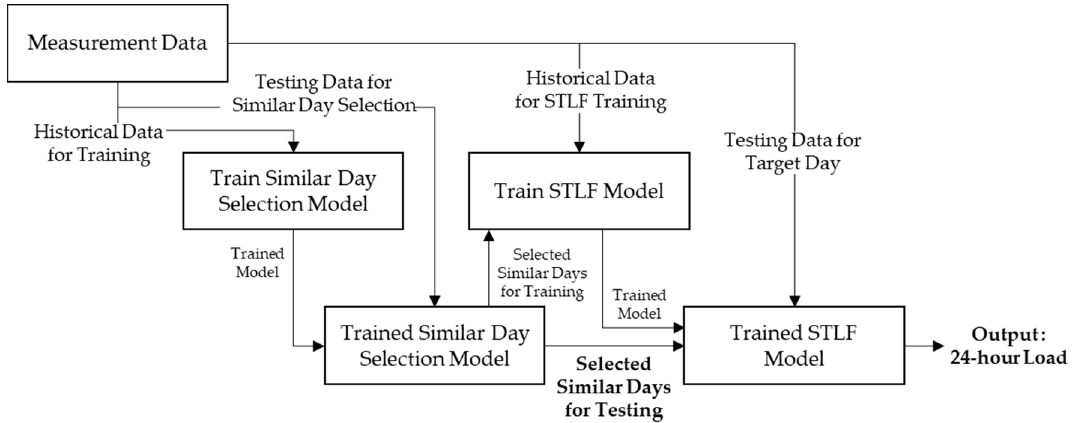
Figure 1. Overall procedure of the proposed algorithm.